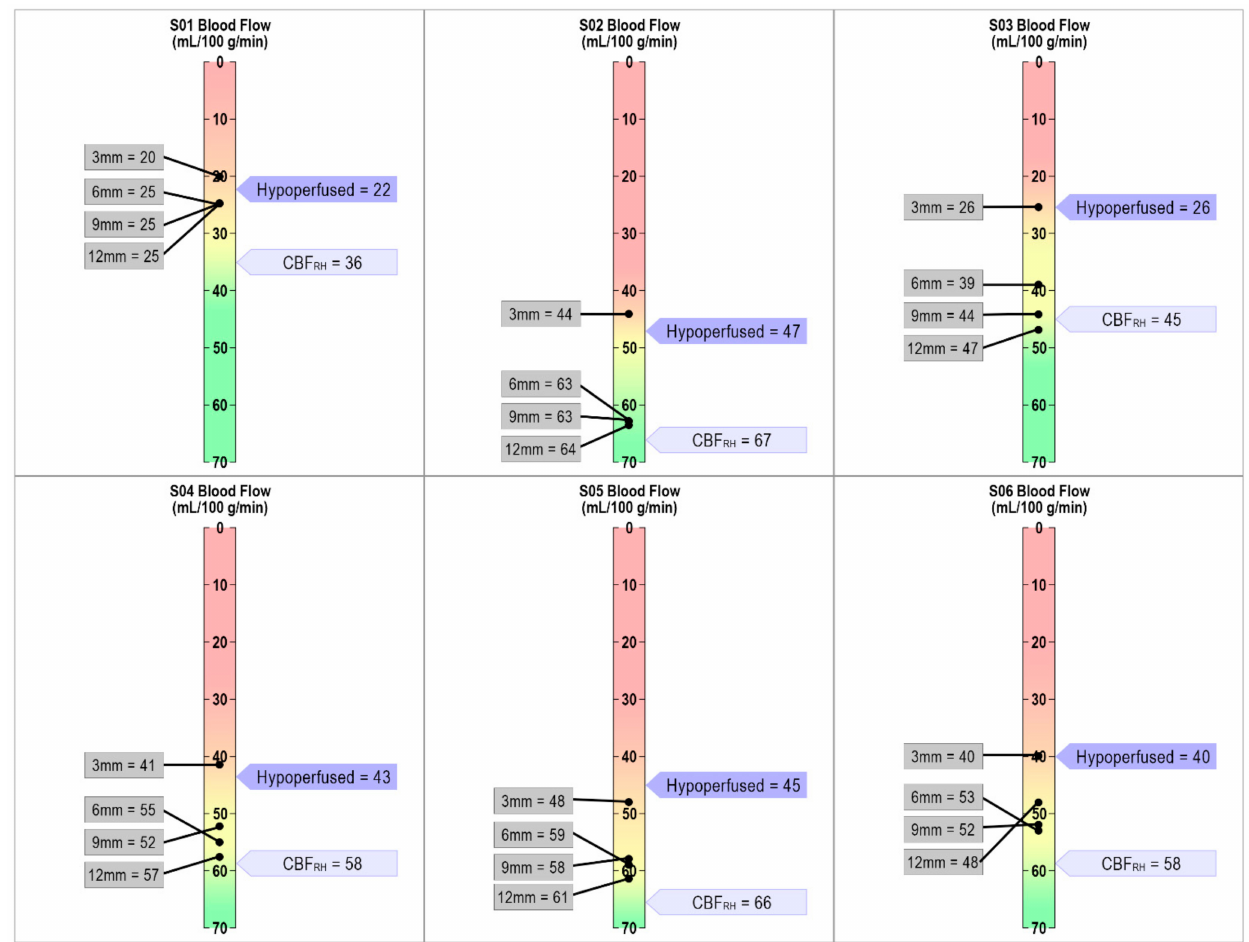
Figure 3. Individualized CBF threshold maps for each participant. The dark purple flag indicates when tissue is hypoper- fused based on the individually defined approach of 1.5 SD below CBF RH . The light purple flag indicates average CBF RH . The gray boxes show CBF values for each of the four 3mm perilesional bands. As can be seen in the figure, the 0–3mm band is either at or below the individually defined threshold for hypoperfusion for each